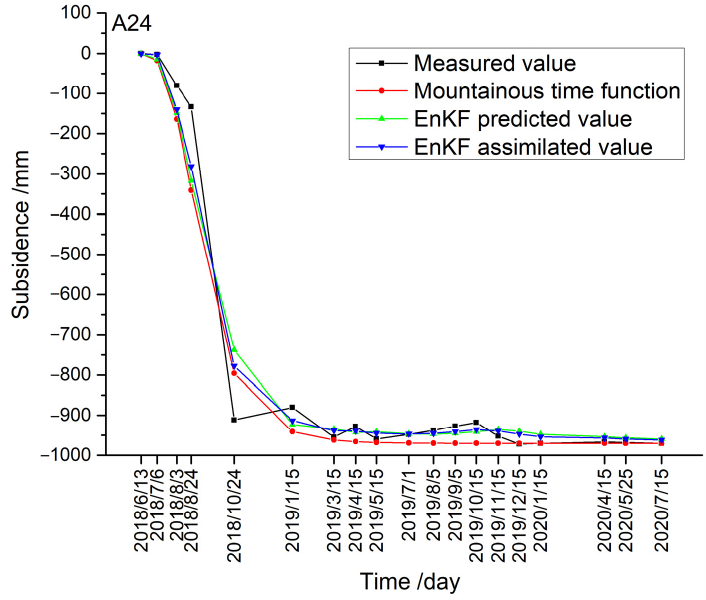
Figure 6. Subsidence curves of A24 using different methods.